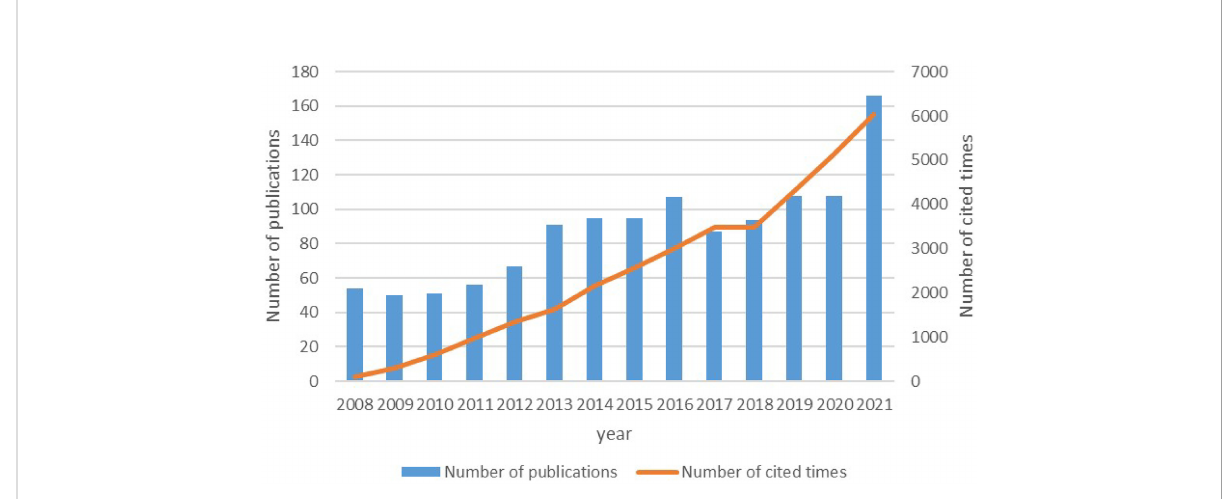
FIGURE 2 Trend of the number of articles published annually and the total amount of citations of annual